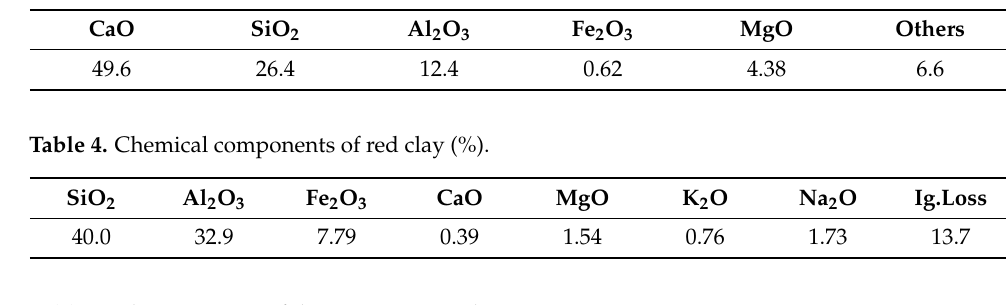
Table 5. Characteristics of the aggregate